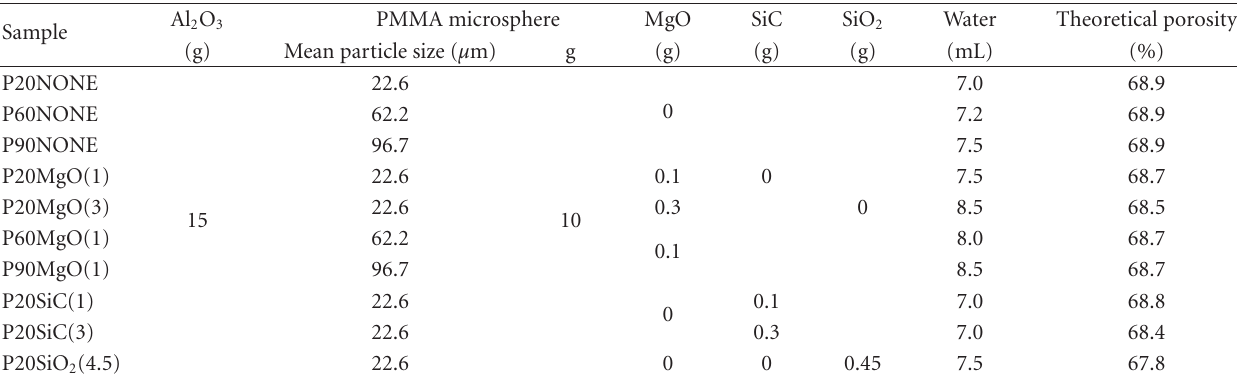
Table 1: Compositions of slurries used for